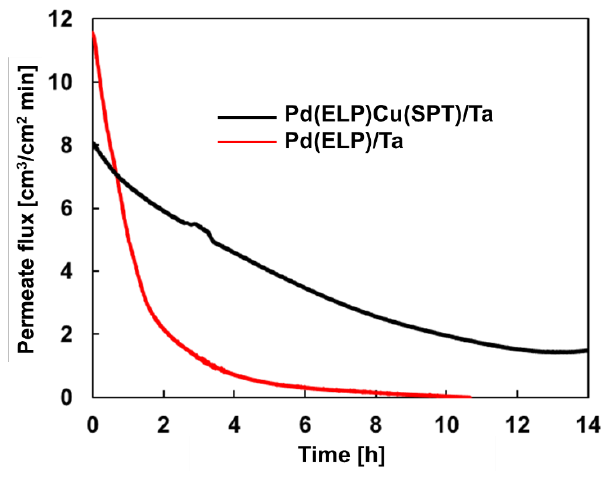
Figure 12. The comparative temporal stability test of Pd(ELP)/Ta and Pd(ELP)Cu(SPT)/Ta mem-